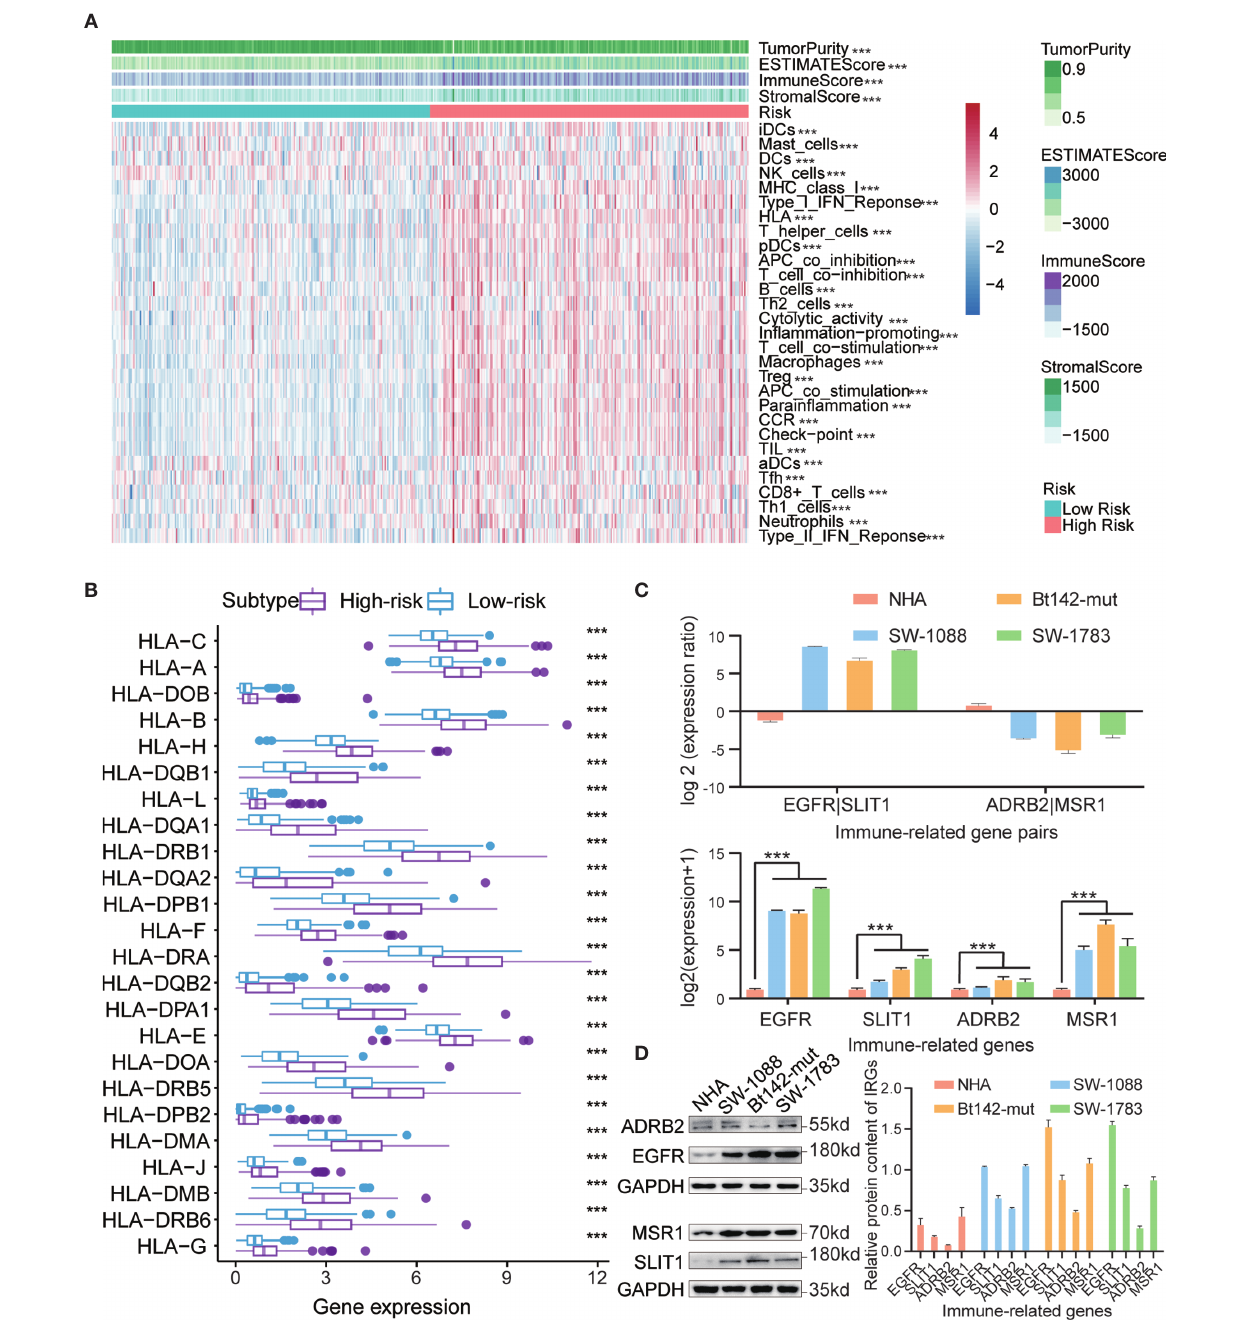
FIGURE 7 | (A) Hierarchical clustering of primary low-grade glioma (LGG) patients into high- and low-risk subgroups based on the immune-related gene pair (IRGP) signature. Tumor purity, estimated scores, immune scores, and stromal scores were assessed by ESTIMATE, based on 29 immune-associated gene sets. (B) Comparison of human leukocyte antigen (HLA) genes between high- and low-risk subgroups. (C) qRT-PCR analysis of four IRGs in NHA, SW-1088, Bt142-mut, and SW-1783 cells. Expression was normalized against glyceraldehyde 3-phosphate dehydrogenase (GAPDH) mRNA expression. Data are presented as the mean ± SEM. (D) Western blotting analysis was performed to measure IRG protein levels in NHA, SW-1088, Bt142-mut, and SW-1783 cells. *** P <